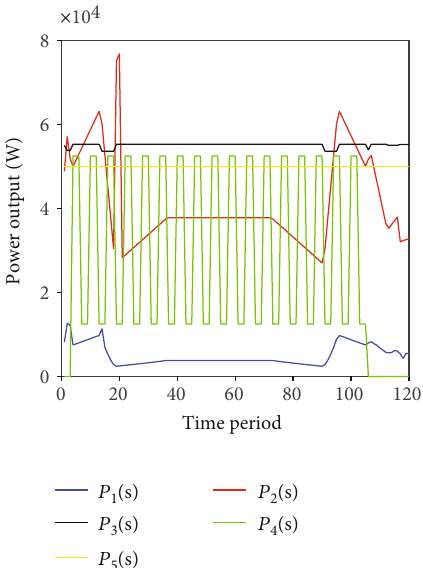
Figure 7: All electrical load results under standard cruise altitude, speed, mass, and gravity center position.